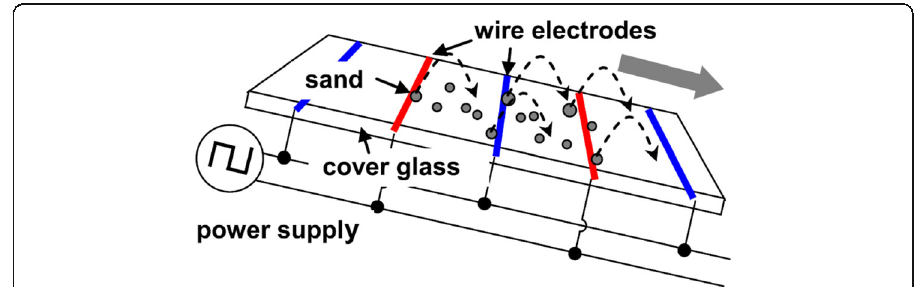
Fig. 11 Schematic diagram of the electrostatic cleaning system that uses a standing wave and gravity to remove sand from a solar panel